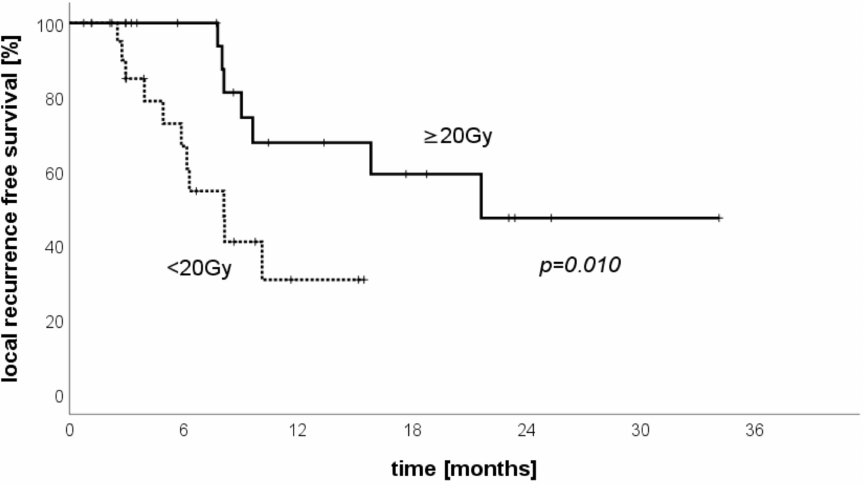
Figure 3. Local-recurrence-free survival for histology of colorectal carcinoma (CRS) stratified by